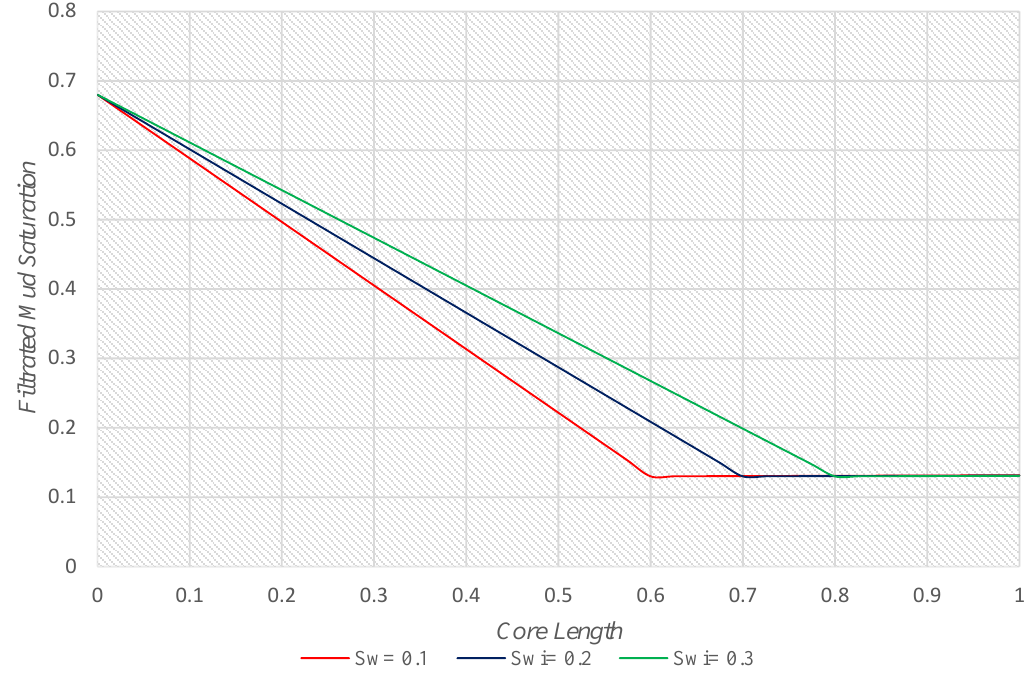
Figure 3. Water Saturation Effect on the filtrated mud saturation.